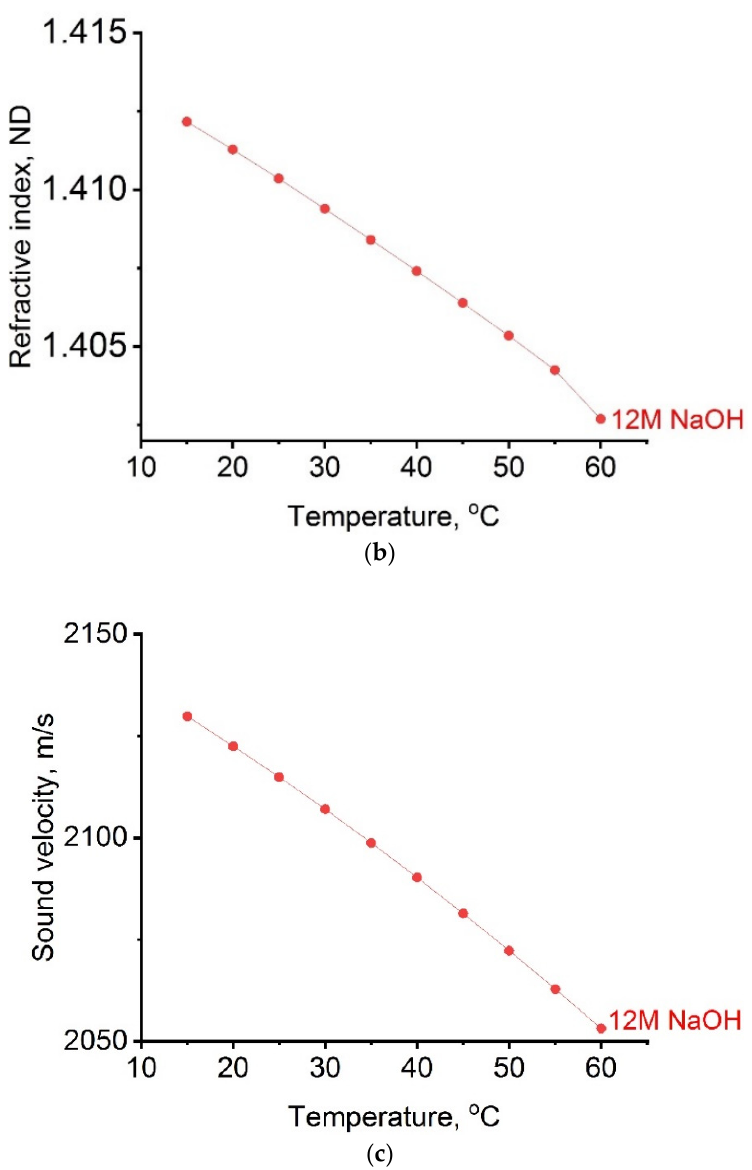
Figure 1. Influence of temperature on: ( a ) density, ( b ) refractive index, ( c ) velocity of sound on alkaline activator.